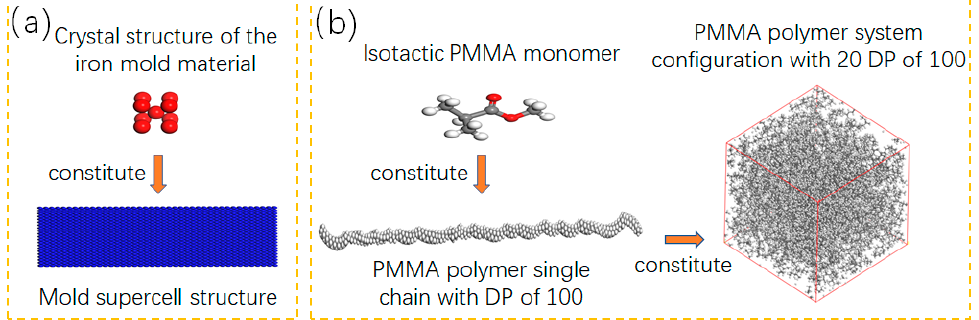
Figure 1. Construction of the polymethyl methacrylate (PMMA) polymer molecular dynamics model: ( a ) Mold supercell structure; ( b ) PMMA polymer system configuration with 20 DP of 100.